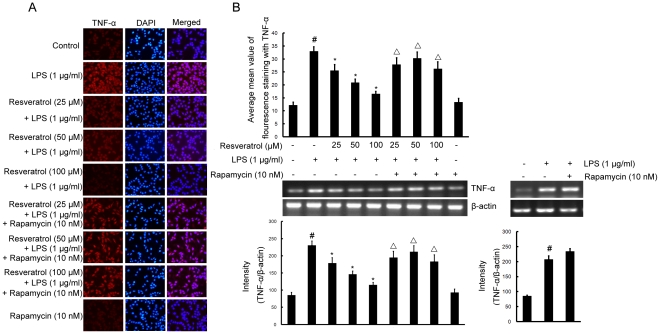
mTOR is involved in resveratrol-attenuated the production of the proinflammatory cytokine TNF-α at the transcriptional and translational levels in BV-2 cells.Panel A shows the immunofluorenscence images for protein expression of TNF-α and Panel B shows the corresponding mRNA data. The relative mRNA level was quantified by scanning densitometry and normalized to β-actin mRNA. Note the up-regulated protein and mRNA expression of TNF-α by LPS is suppressed by different concentrations of resveratrol; however, in cells pretreated with mTOR inhibitor rapamycin, the suppressive effect of resveratrol is abrogated. The values shown are mean ± SEM of data from three independent experiments. #Significant compared with control alone, p<0.05. *Significant compared with LPS alone, p<0.05. ▵Significant compared with resveratrol+LPS, p<0.05.